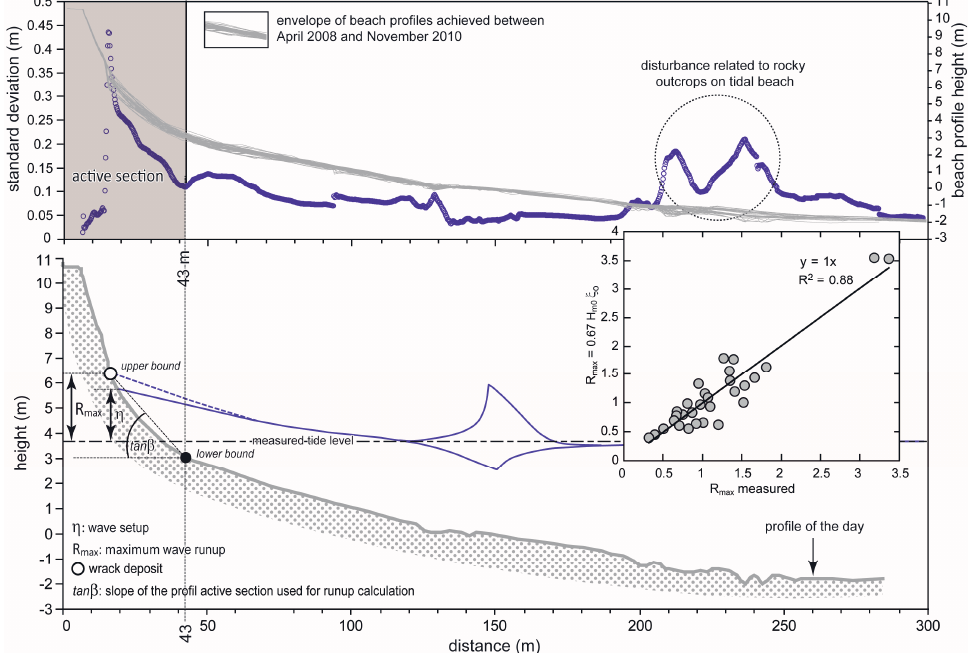
Figure 1. Method used by Cariolet and Suanez [33] to calculate beach slope for the runup calculation. The lower bound corresponds to the limit of the profile section where changes of elevation are the most significant. This section concerns the upper part of the profile, and it is called “active section”. This limit of 43 m has been defined by calculating the standard deviation of height changes of the beach profiles (gray lines) measured between April 2008 and November 2010 (see Table 1). The upper bound corresponds to field measurements of the swash height given by the water mark limit or wrack line